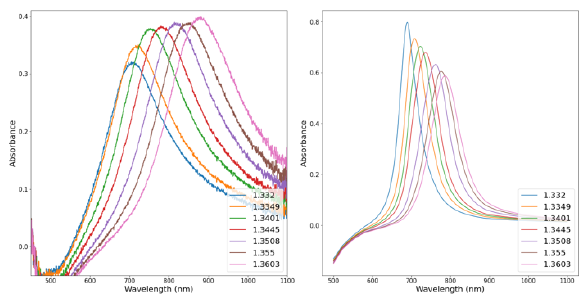
Fig. 2. Absorbance spectra of SPR wave supported on Au thin film: a) Experimental results, b) transfer matrix simulations.